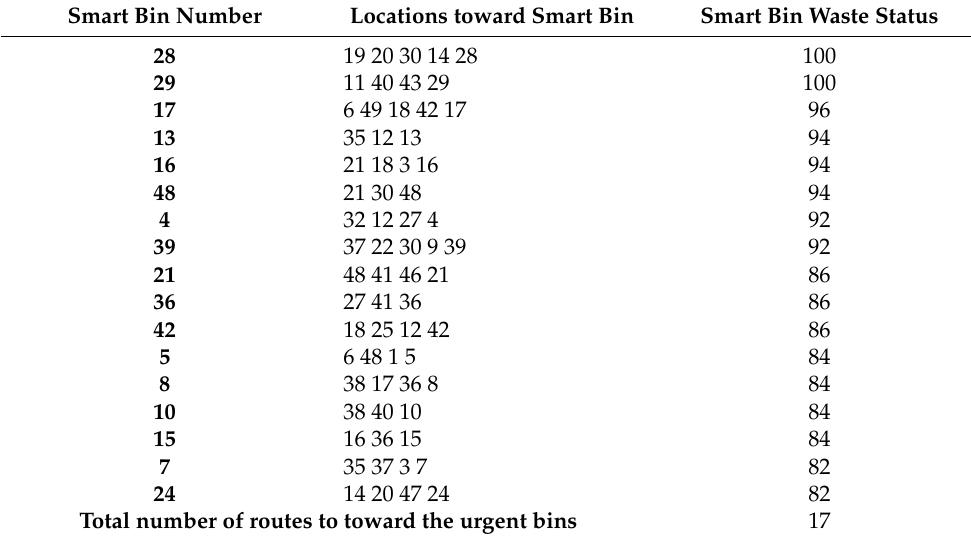
Table 6. Routes to urgent smart bin locations-Type